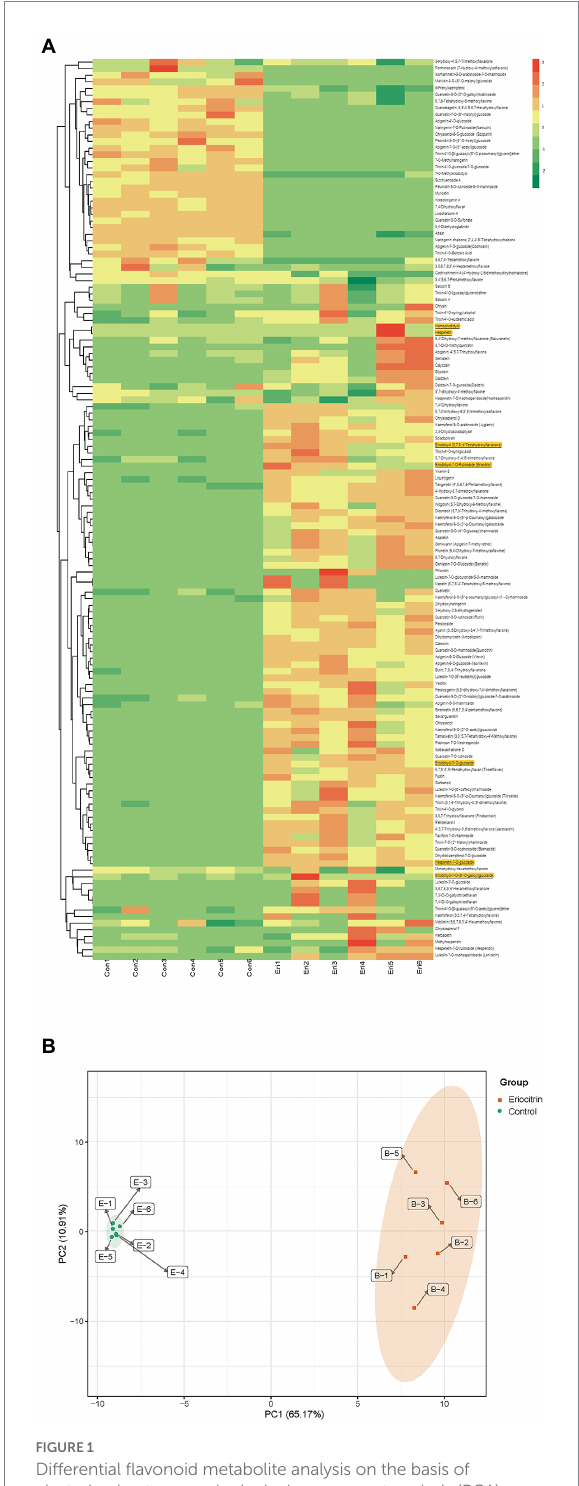
FIGURE 1 Differential flavonoid metabolite analysis on the basis of clustering heatmap and principal component analysis (PCA). (A) Clustering heatmap of all flavonoid metabolite, the metabolite content data was normalized by maximum difference normalization method. Each sample is visualized by a separate column and each metabolite is represented by a separate row, up-regulated and down-regulated metabolites are expressed in shades of red and green, respectively. (B) PCA score plot. Eir, eriocitrin; Con,